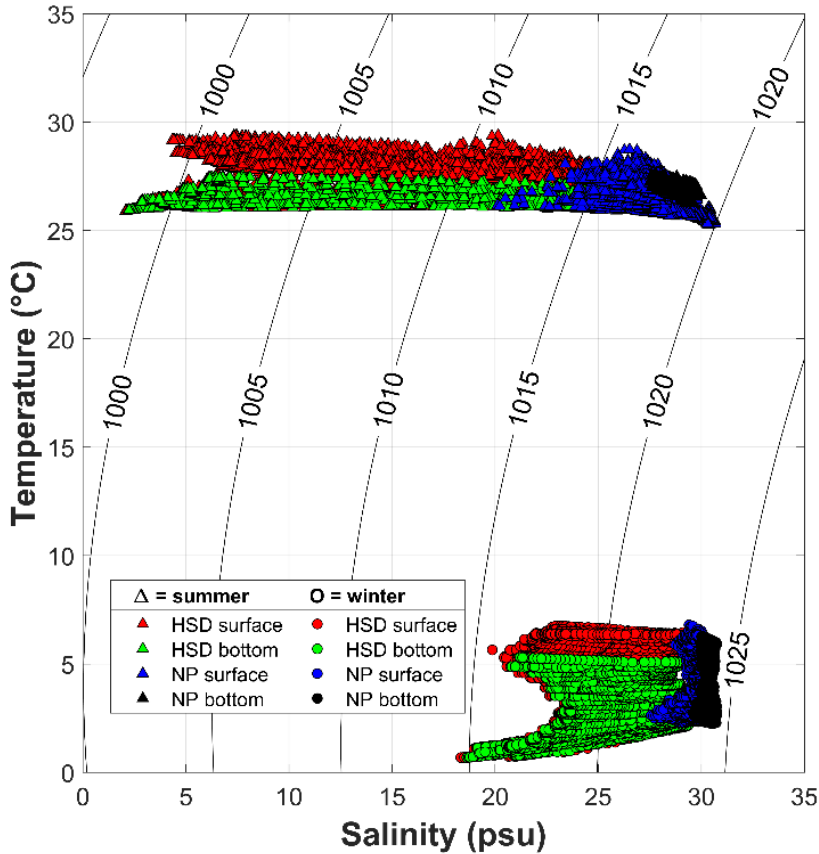
Figure 3. Temperature/salinity (TS) diagram using Conductivity, Temperature, Depth (CTD) obser- vations at HSD and NP in winter (11 February–15 March 2019) and summer (24 July–29 August